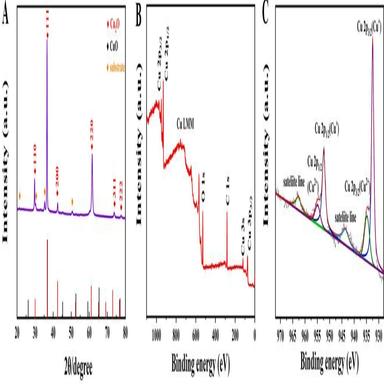
(A) XRD pattern and (B) XPS survey spectrum of ITO/Au/Cu2O. (C) Binding energy spectrum of Cu 2p.